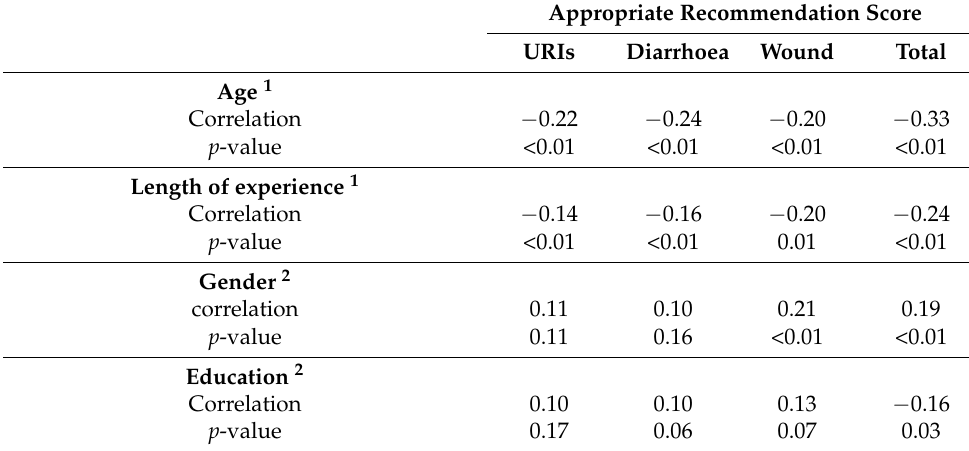
Table 5. Bivariate correlation between demographic data and appropriate recommendation score on antibiotic supply among community